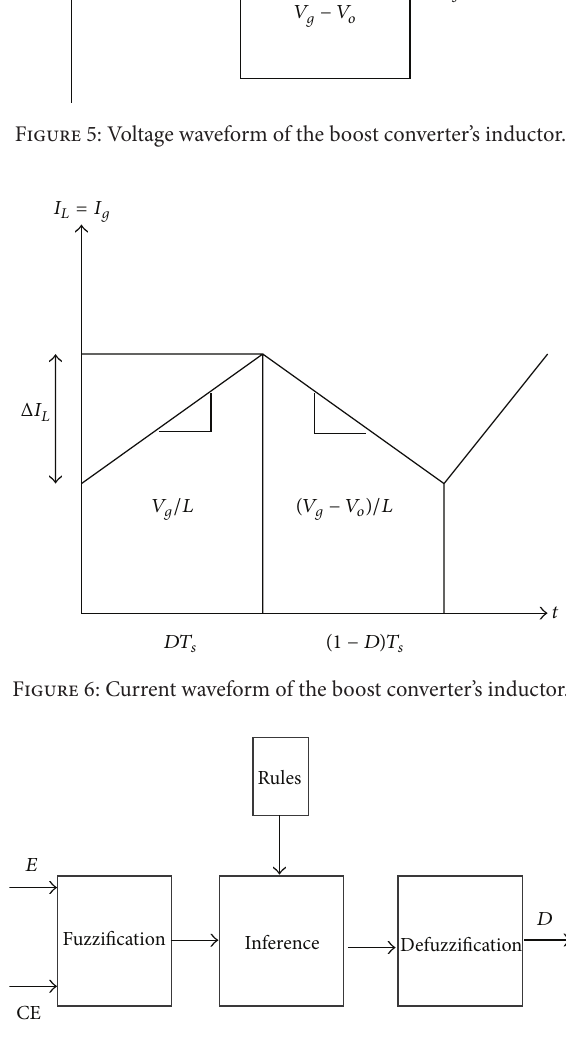
Figure 7: Fuzzy logic